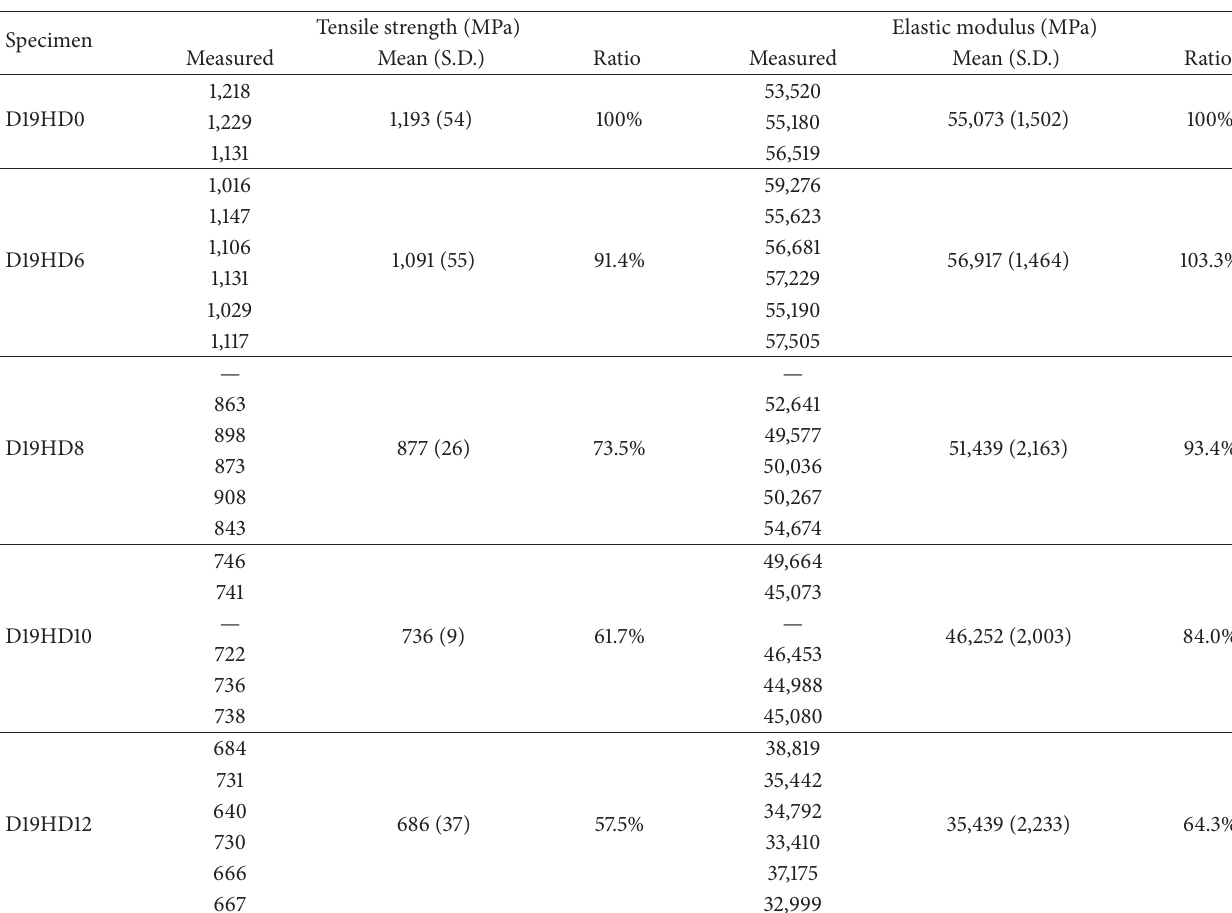
Table 3: Tensile test results.